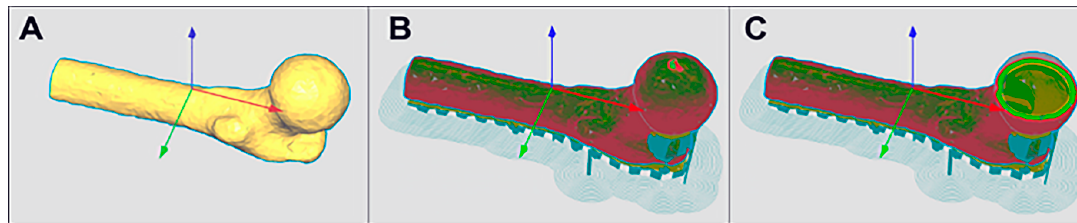
Figure 1. ( A ) The 3D femur model reconstructed from the CT images of a deidentified real patient. ( B ) The hollow mold model which was used to 3D print the Polyvinyl Alcohol (PVA) mold. ( C ) demonstrates the hollow interior space within the reconstructed model shown ( A ). The arrows indicate the X, Y and Z axes.